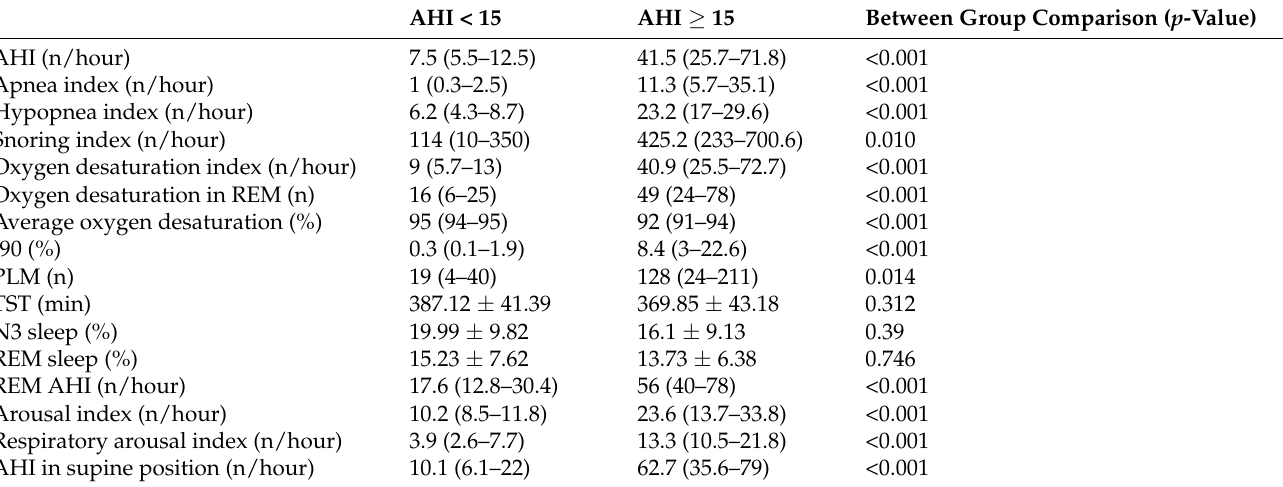
Table 2. Sleep parameters in obese individuals with mild or moderate to severe obstructive sleep apnea. AHI < 15 Between Group Comparison ( p -Value)